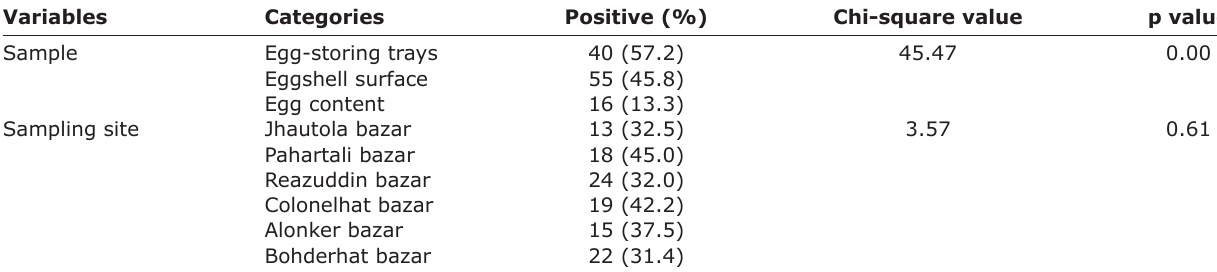
Table-1: Prevalence of Salmonella in different samples and sampling sites. Variables